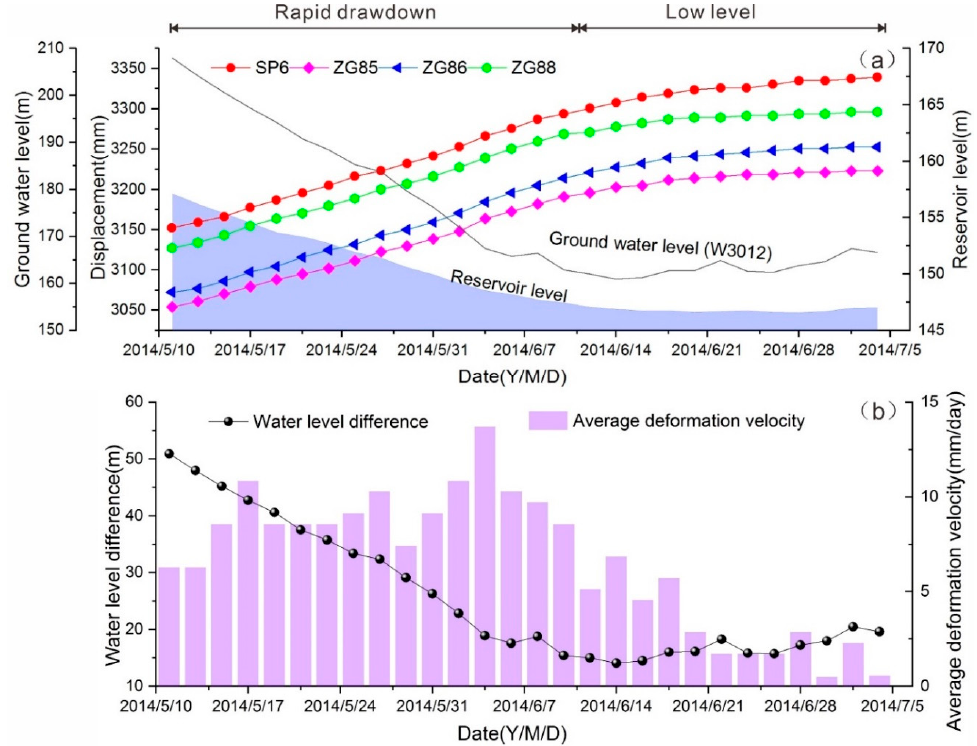
Figure 4. ( a ) Daily monitoring data of accumulative displacement and water level in the periods of rapid drawdown and low water level in 2014. ( b ) The relationship between the deformation velocity and the water level difference.